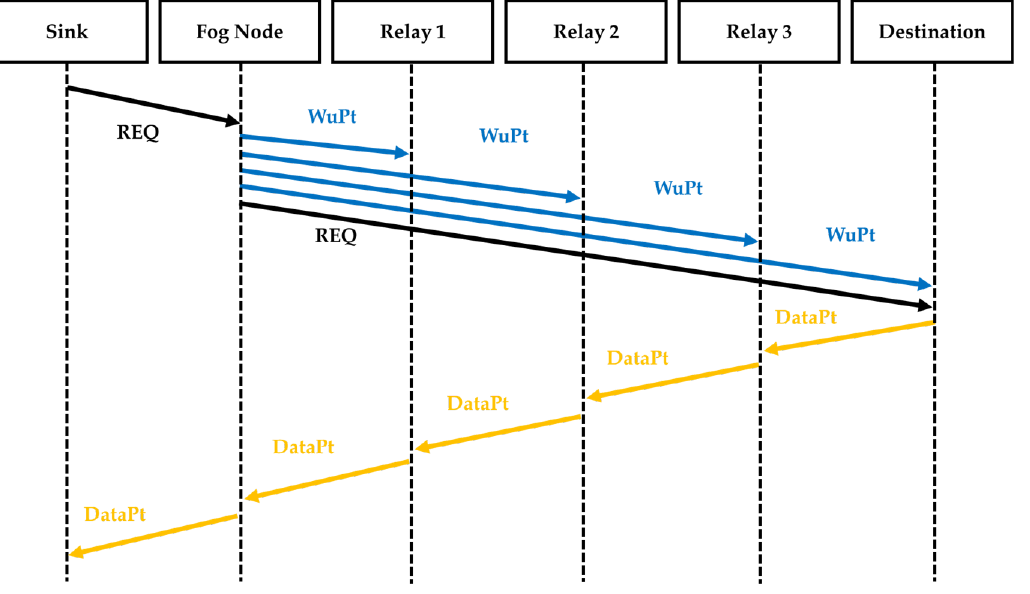
Figure 8. Sequence diagram of the SBS